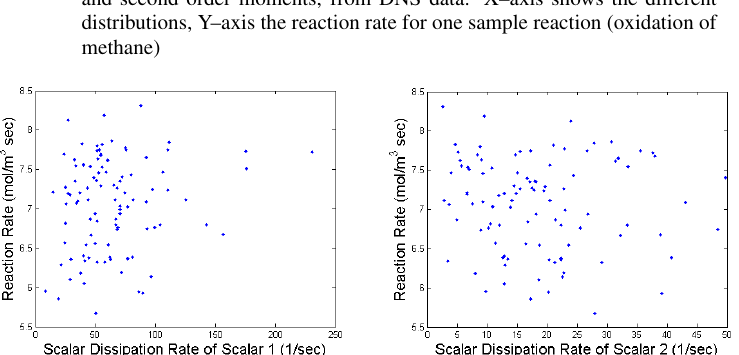
Fig. 8 Reaction rate vs. the scalar dissipation rates